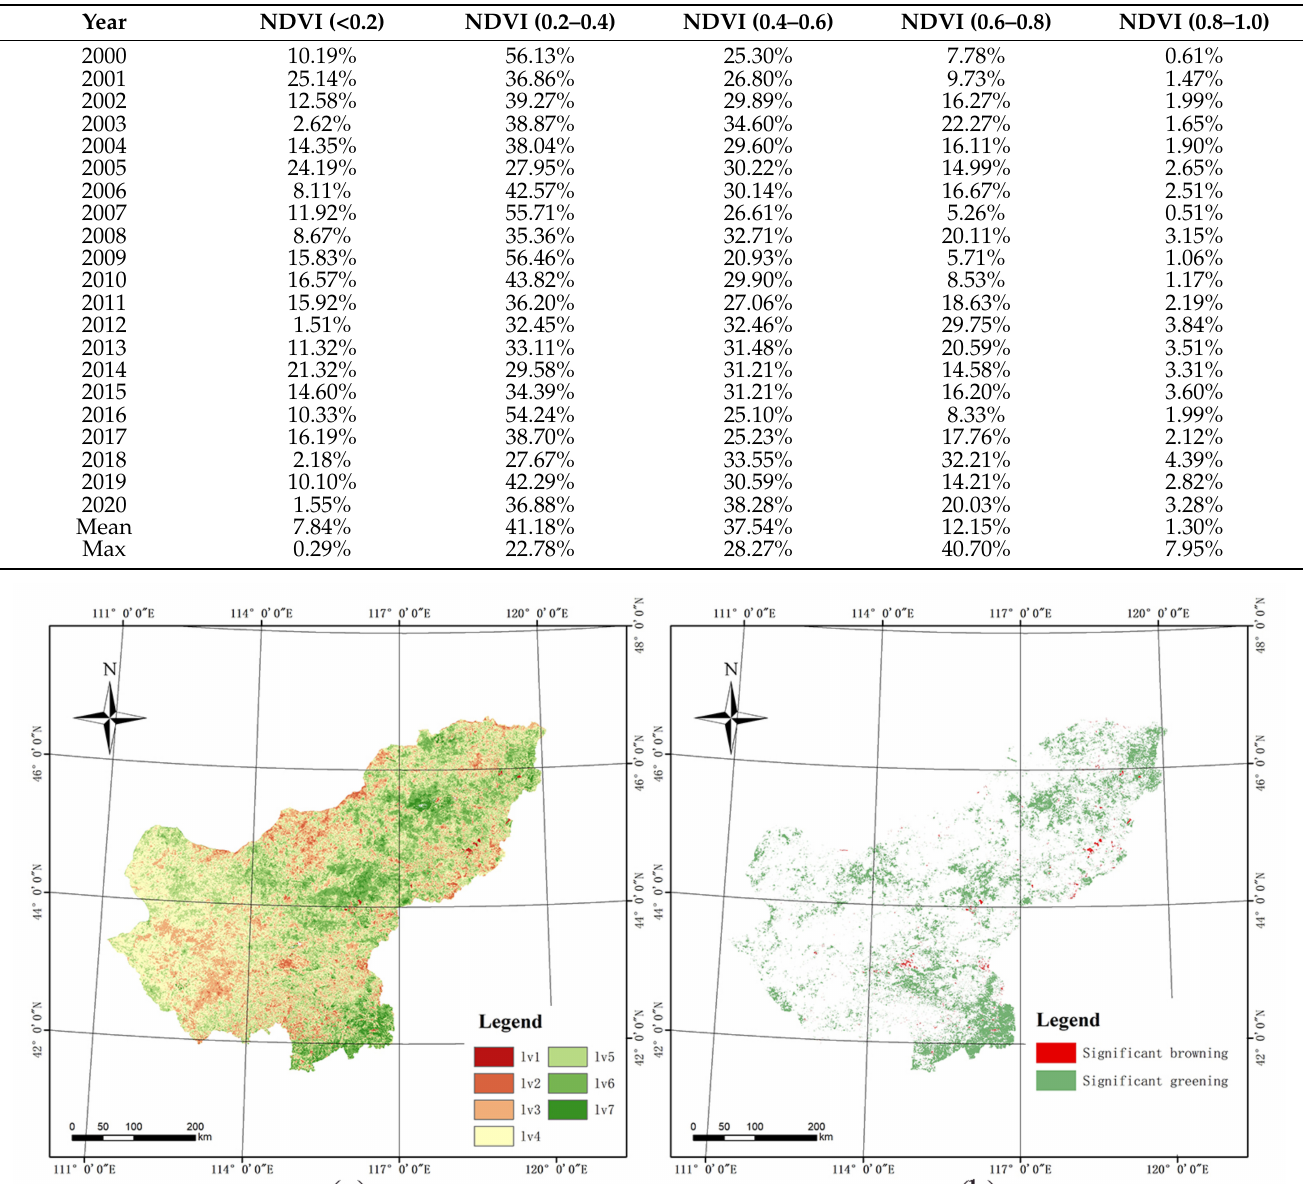
Table 1. The proportions of the area covered by different NDVI categories in the Xilin Gol League between 2000 and 2020.